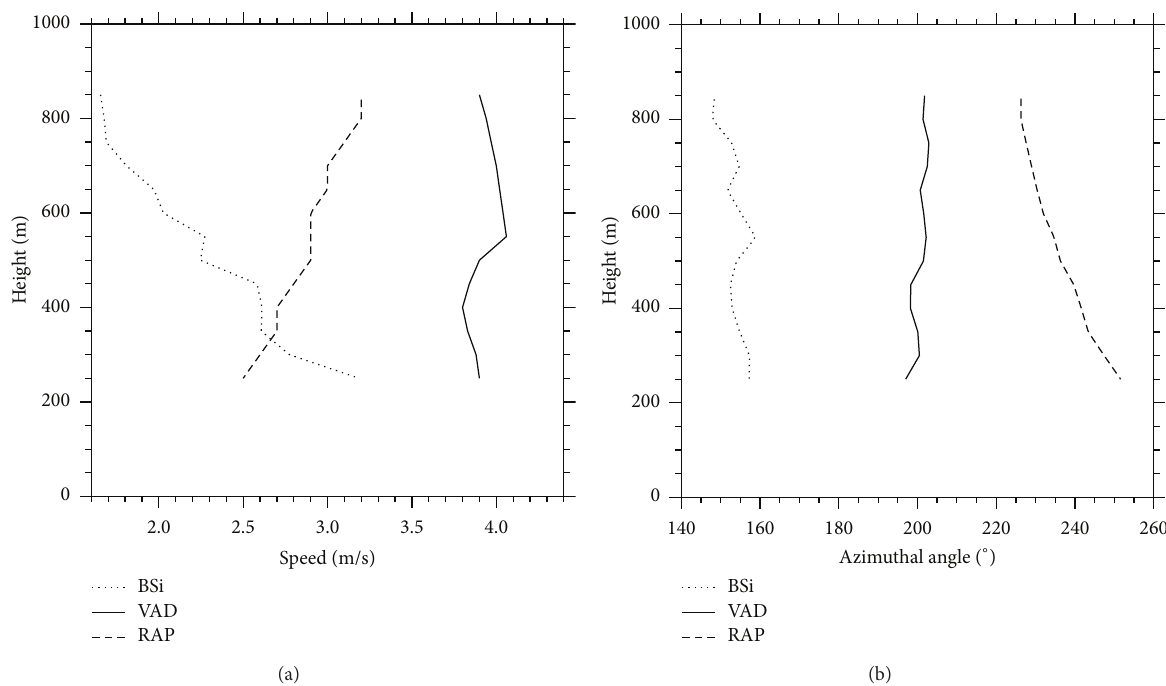
Figure 10: As in Figure 8 except that the VAD velocity (plotted by the solid profiles) is produced from the KICT-scanned volumetric velocity data at 215542 UTC with all the BSb pixels removed and the interpolated velocity from RAP hourly wind analyses (plotted by the dashed profiles) is also at 215542 UTC on 28 October